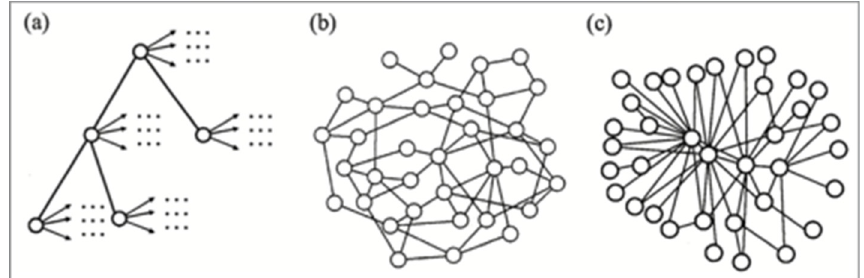
Figure 1. Three illustrations of different types of networks from the selected literature. We can see ( a ) simple networks, ( b ) one possible example of a connectionist network, and ( c ) a complex network. Source: (Steyvers and Tenenbaum 2005).